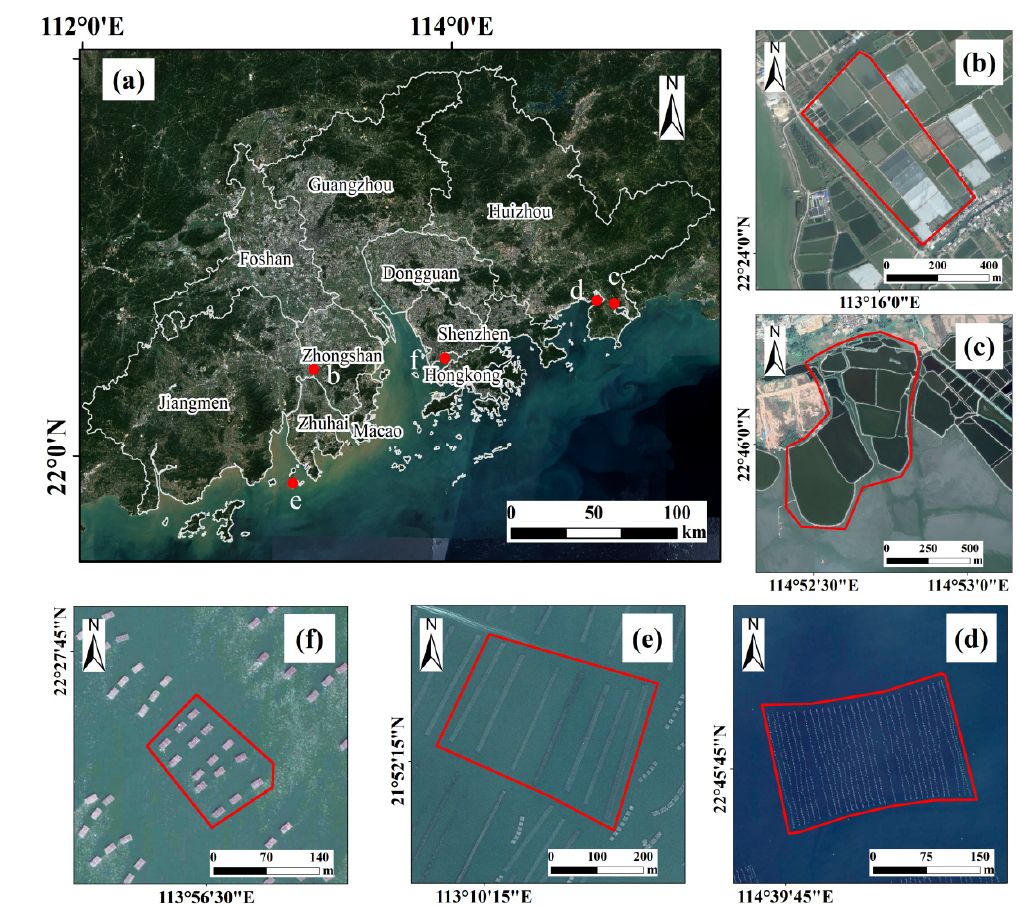
Figure 5. Typical aquaculture samples over the study area in high resolution Google Earth image ( a ): costal aquaculture pond ( b , c ), visible raft aquaculture ( d , e ), and concentrated-distributed cage culture area ( f ).